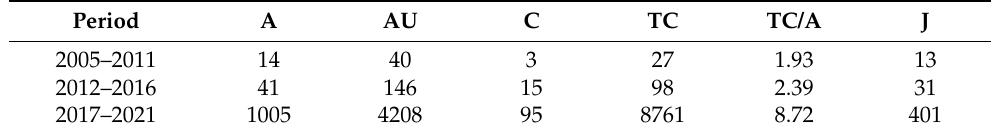
Table 1. CE in the agricultural context: major characteristics